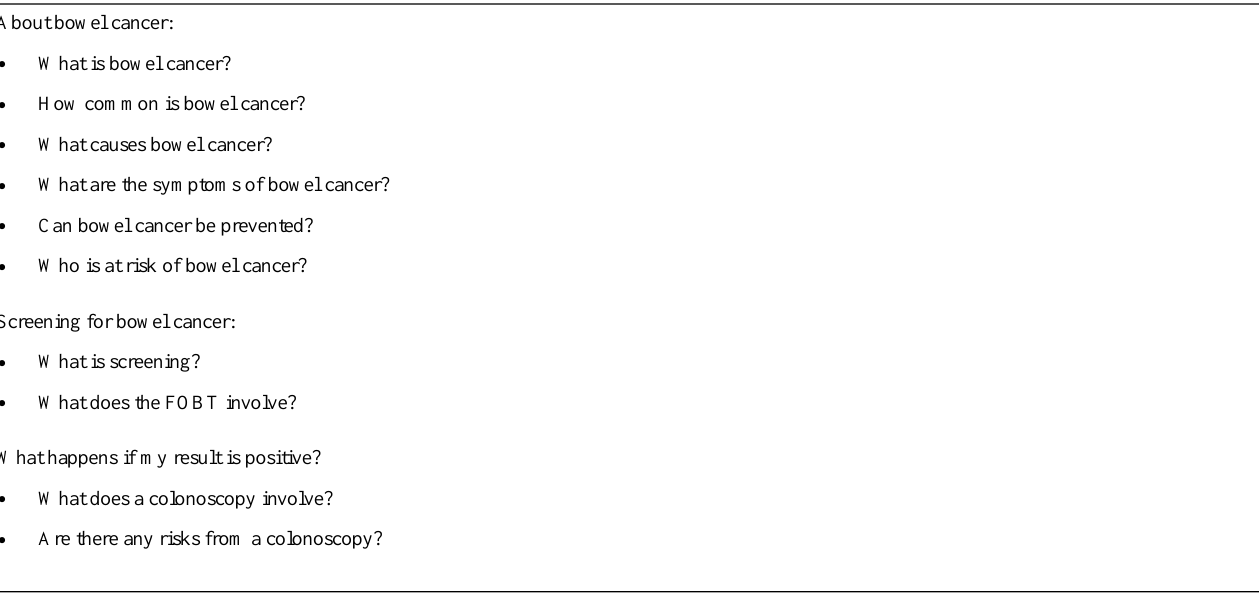
ability for text to be enlarged, contrast to be changed, and use of adequate white space [29]. A sample of the Web page is shown in Figure 2.